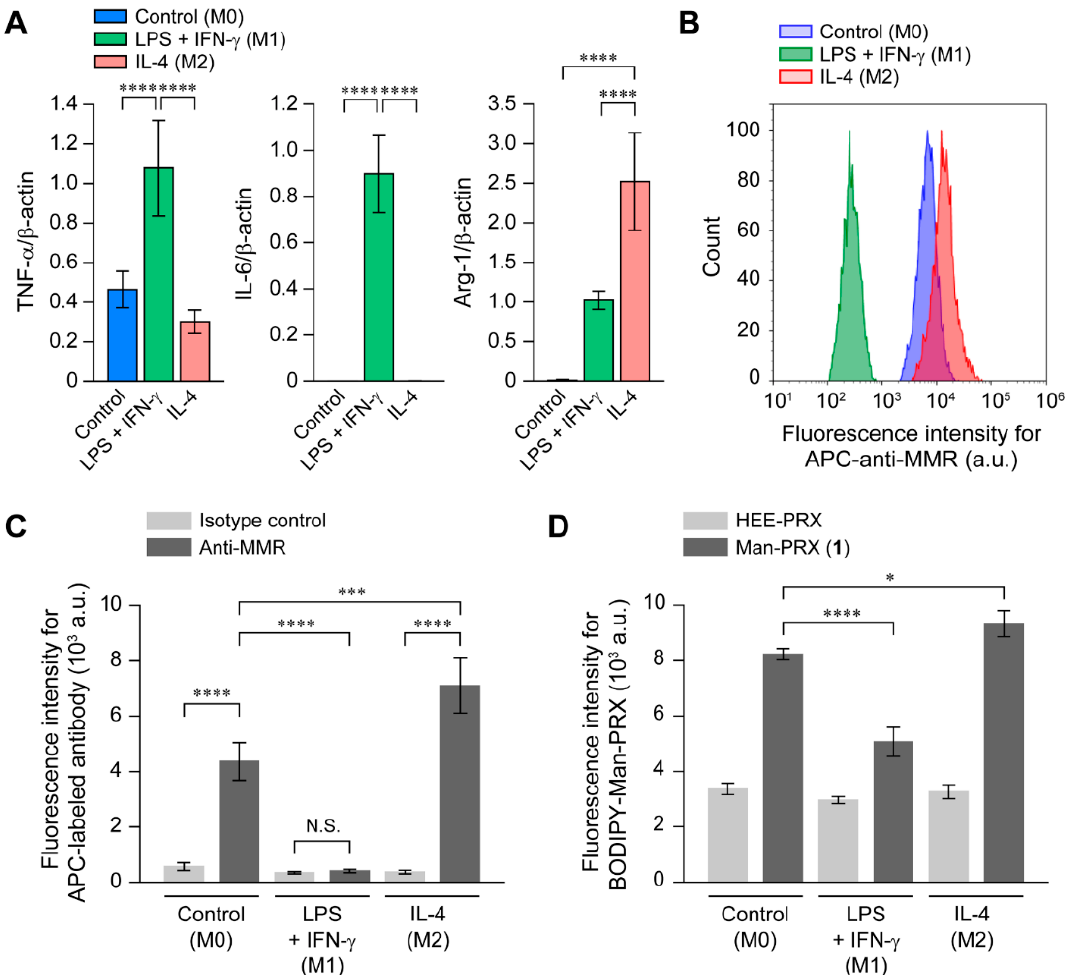
Figure 8. ( A ) mRNA expression levels of TNF- α , IL-6, and Arg-1 in RAW 264.7 cells polarized with LPS (100 ng/mL) + IFN- γ (100 ng/mL) (M1 polarization), or IL-4 (400 ng/mL) (M2 polarization), for 24 h. The phenotype of untreated RAW264.7 cells was denoted as M0. The expression levels of each gene were normalized by the expression level of the β -actin gene (n = 4). ( B , C ) The fluorescence intensity of RAW264.7 cells polarized with LPS + IFN- γ or IL-4 for 24 h, followed by treatment with the APC-labeled IgG2a, κ isotype control and APC-anti-MMR antibody (n = 3). ( D ) The fluorescence intensity of RAW264.7 cells polarized with LPS + IFN- γ or IL-4 for 24 h was followed by treatment with BODIPY-HEE-PRX (10 µ M) and BODIPY-Man-PRX (10 µ M) for 3 h. Data are expressed as mean ± standard deviation (n = 3, * p < 0.05, *** p < 0.005, and **** p < 0.001. N.S. indicates no significance).